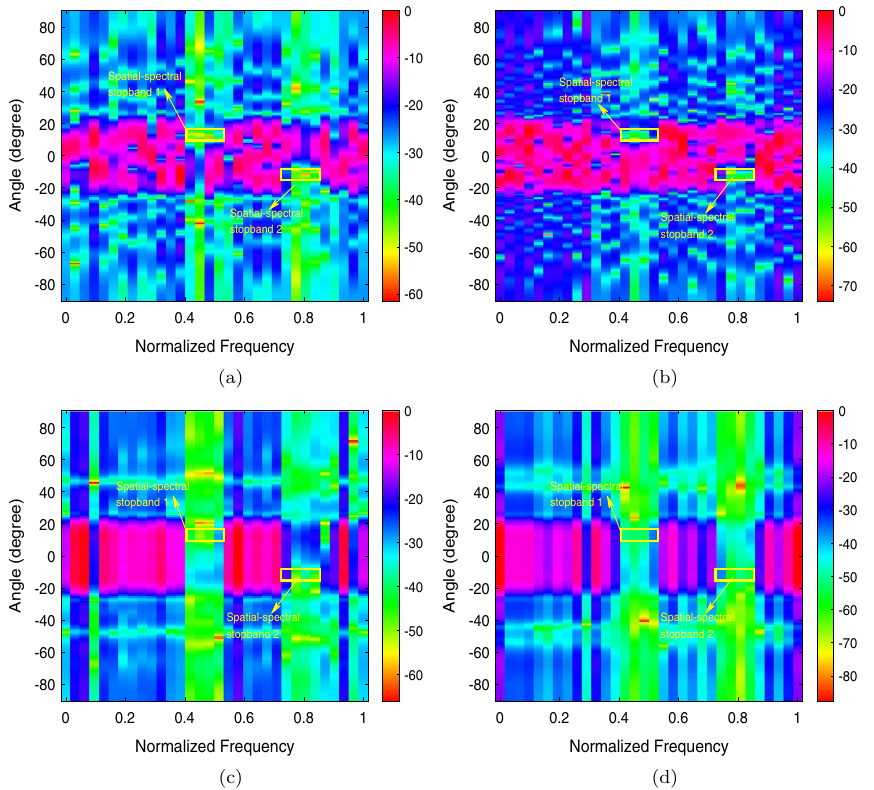
100 under different array = 1. d SA with PVPR ≤ =